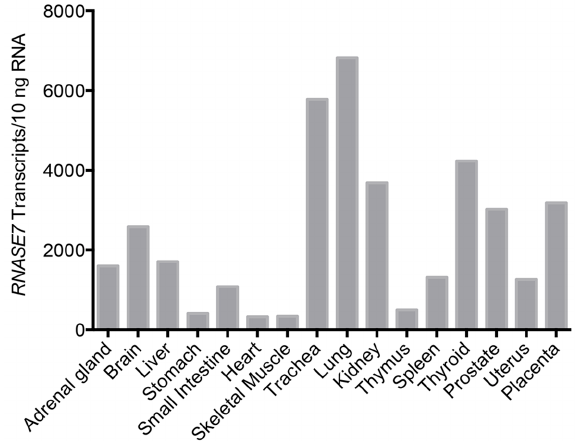
Figure 2. Tissue distribution of RNASE7 mRNA expression. RNA from various human tissues was reverse transcribed and RNASE7 gene expression was analyzed by quantitative real-time PCR. Figure adapted from [21]. Int. J. Mol. Sci. 2016 , 17 , 423